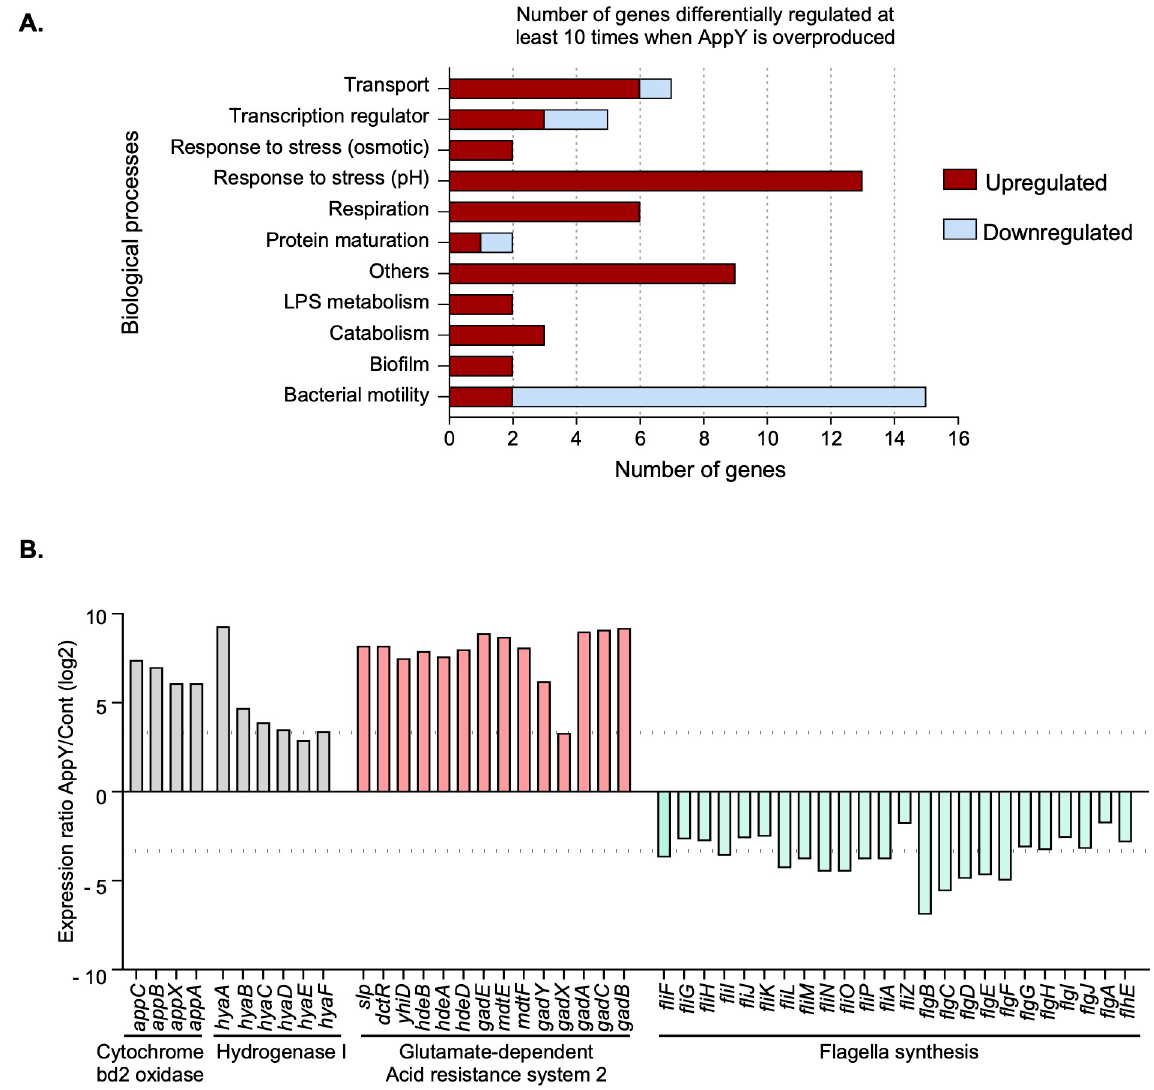
Fig 1. Identification of AppY regulon by RNA-Seq experiments. MG1655 Δ rpoS strain transformed with plasmids pQE80L or pQE80L- appY were grown to an OD 600 * 0.6 and appY expression was induced with 1 mM IPTG for 1 hour. RNA was purified, reverse-transcribed and sequenced. The data shown are representative of three independent experiments. A. Global overview of genes regulated at least 10 times by AppY. Genes up-regulated (dark red) and down-regulated (light blue) at least 10 times (Log2 Fold-Change � 3.2) when AppY was overproduced were classified according to their biological functions. Categories were defined using the Gene Ontology numbers listed in S1 Methods. B. AppY mainly regulates genes involved in aerobic respiration (grey), acid resistance (pink) and flagellar synthesis (green). The dashed lines indicate 10-fold induction or